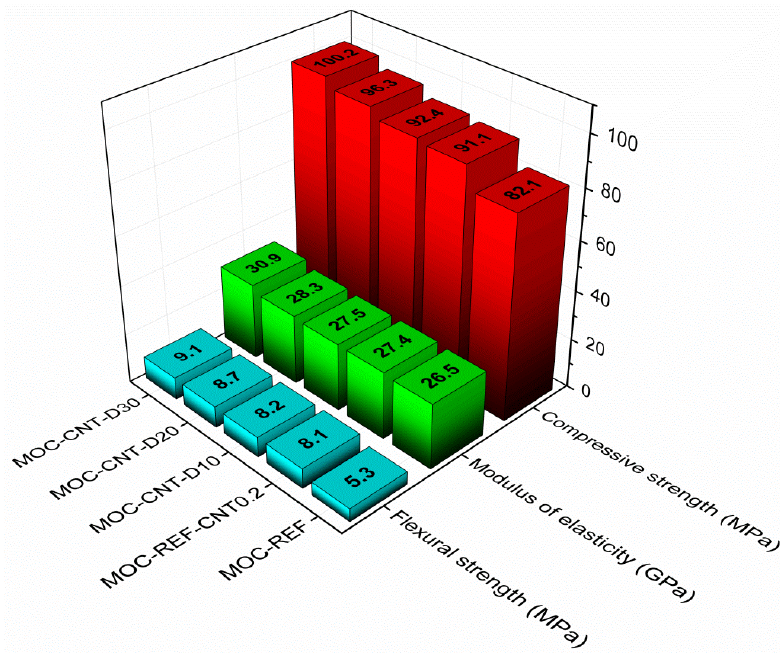
Figure 9. Mechanical parameters of 28 days composites.